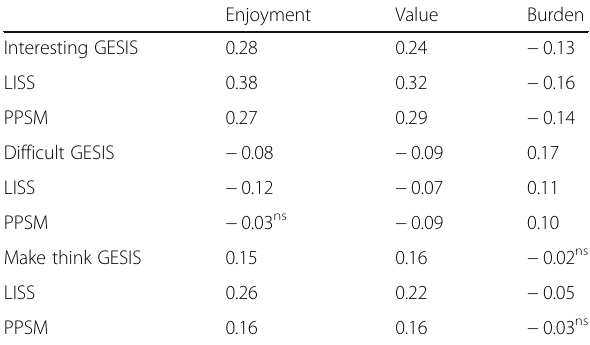
Table 4 Correlations between survey attitude scales and survey evaluation questions for three panels: GESIS, LISS and PPSM